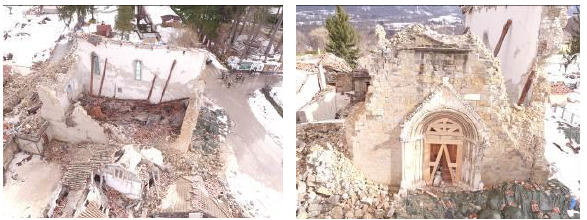
Figure 5. Oblique image of the Sant’Agostino Church; the top of the bell tower and the collapse after the Norcia earthquake; the structure after the January seismic